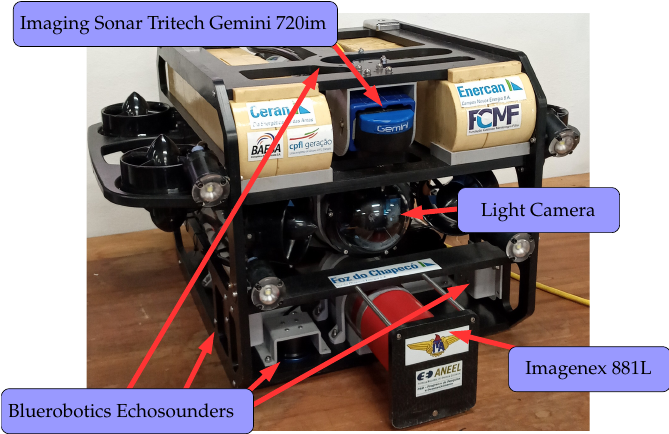
Figure 10. The vehicle VITA1 and its sensors.